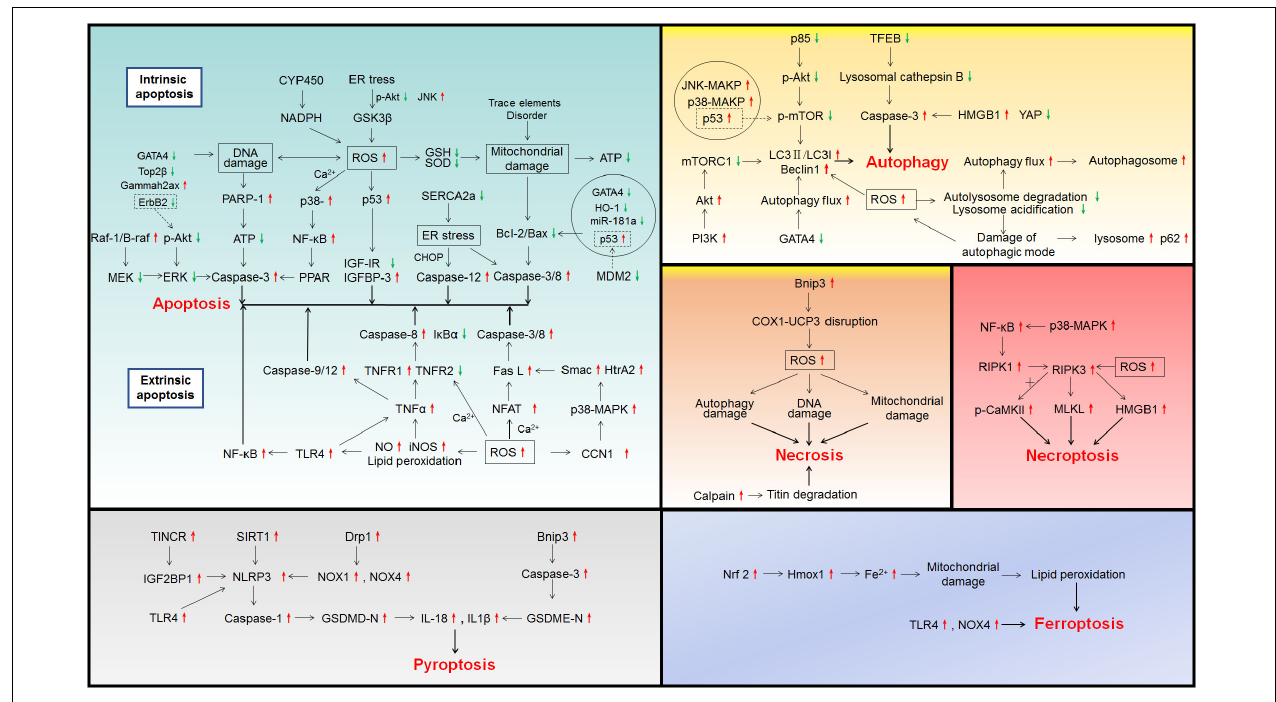
FIGURE 1 | Signaling pathways involved in drug-induced